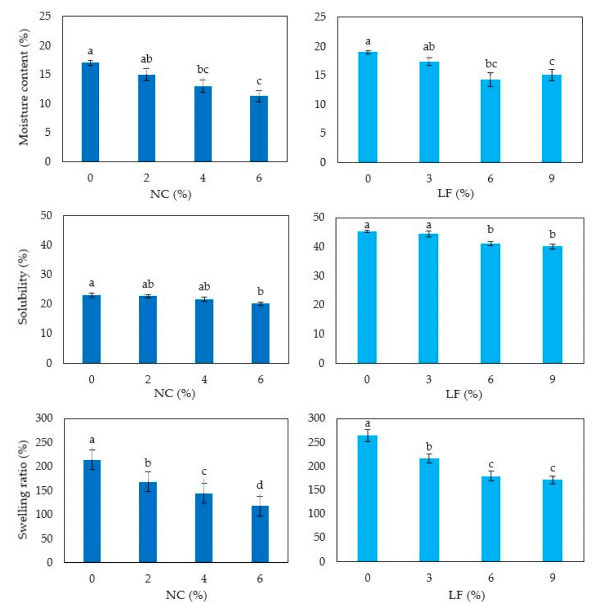
Figure 6. Moisture content, solubility and swelling ratio of hemp protein-based films prepared with film forming solutions containing increasing amounts of either nanocrystalline cellulose (NC) or lignin fraction (LF) and prepared at pH 9 and 12, respectively. Di ff erent small letters a–d indicate significant di ff erences among the values reported in each column ( p < 0.05). Further experimental details are given in text.